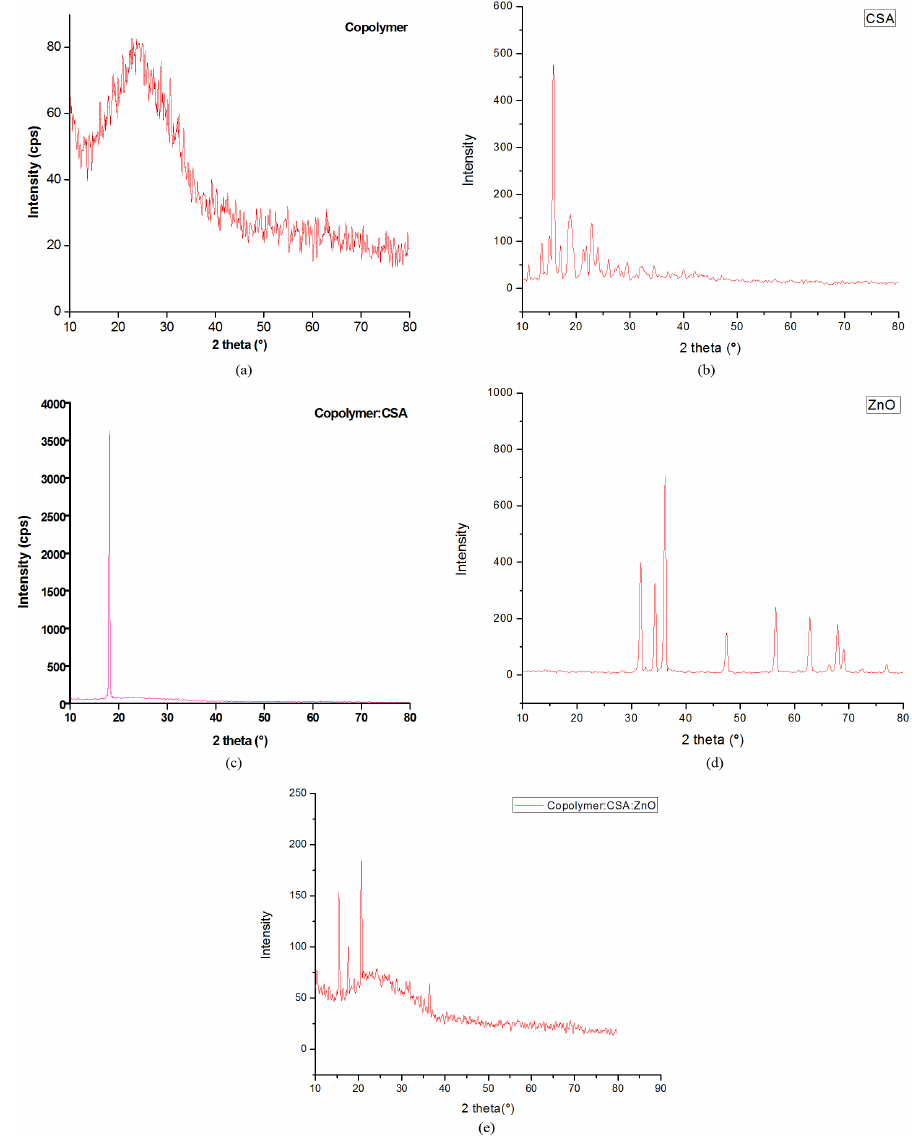
Figure 3. (a) XRD pattern of Copolymer film; (b) XRD pattern of pure CSA; (c) XRD pattern of CSA doped Copolymer; (d) XRD pattern of pure ZnO nanoparticles; (e) XRD pattern of CSA doped Copolymer with ZnO